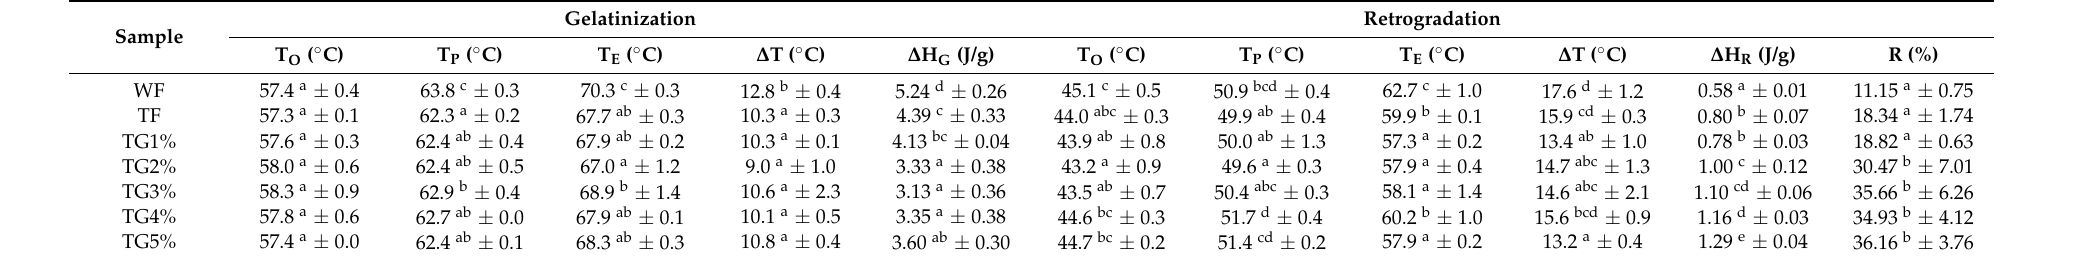
Table 2. Characteristics of gelatinization and retrogradation of systems wheat flour, triticale flour and triticale flour with vital